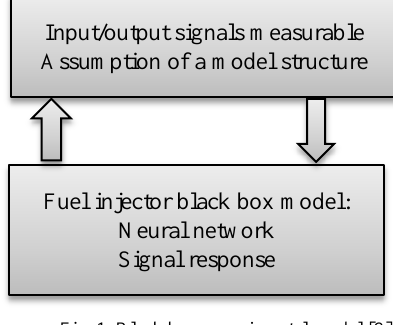
Fig. 1. Black box experimental model